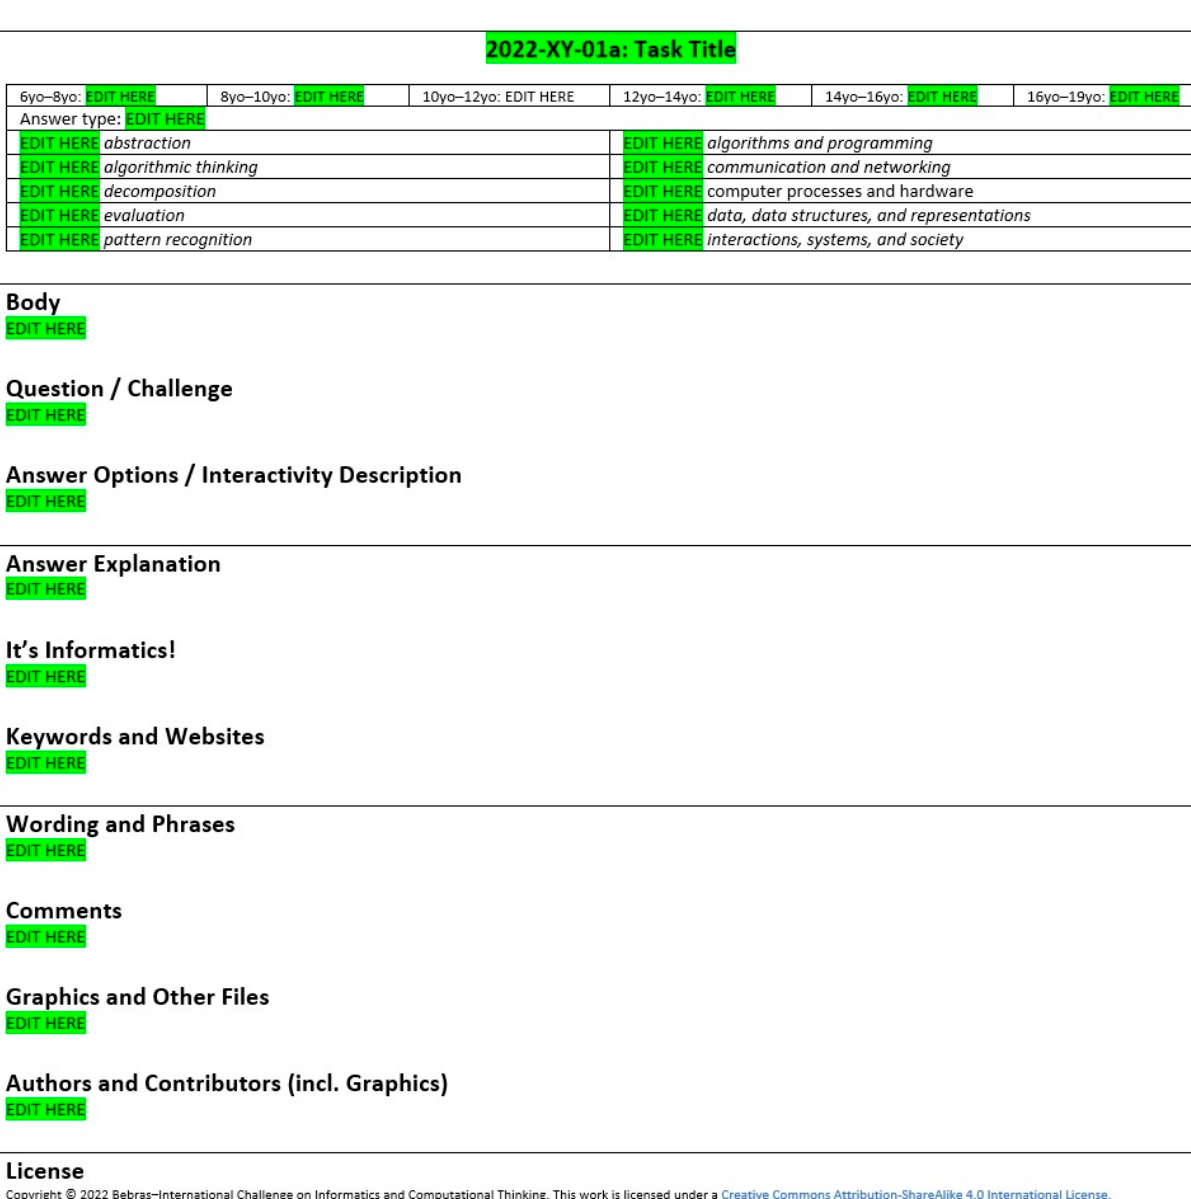
Figure 2. Template for creating a short Bebras task. Retrieved by permission from www.bebras.org (accessed on 24 February 2022).